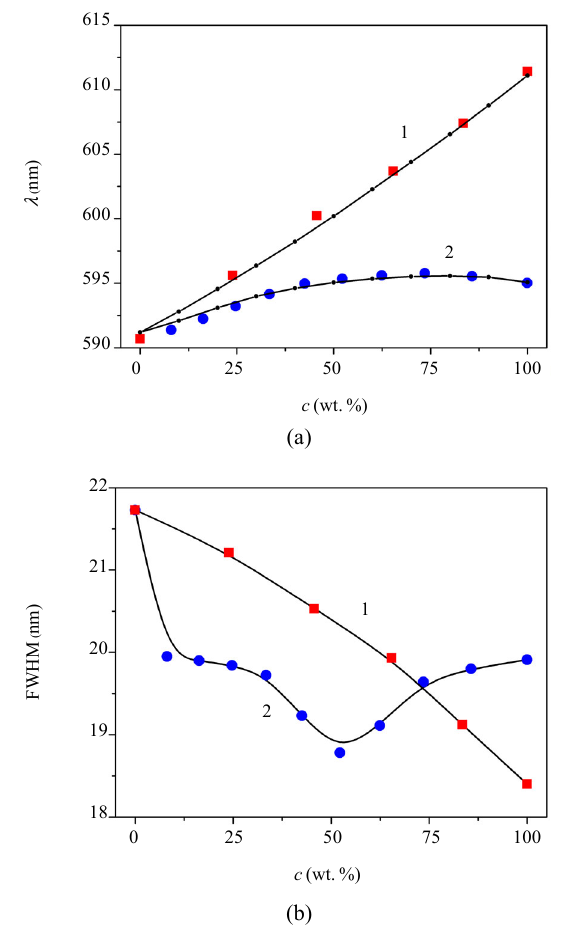
Fig. 5 Dependence of the wavelength (a) and the width (b) of the first stop band of AAO PC on the composition of immersion liquid. Experimental data for water-glycerol (1) and water-ethanol (2) mixtures are shown by squares and circles, respectively. The size of the symbols corresponds to the size of error bars. Black dots connected by lines in (a) are calculated data in accordance with (1) and (2) using reference data on the refractive indices [34]. Solid lines in (b) are given just for eye